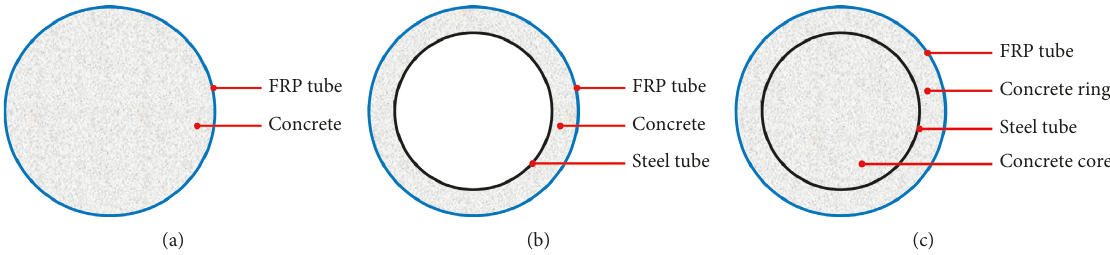
Figure 1: Cross sections of columns with an FRP tube. (a) CFFTs. (b) Hybrid DSTCs. (c) Hybrid